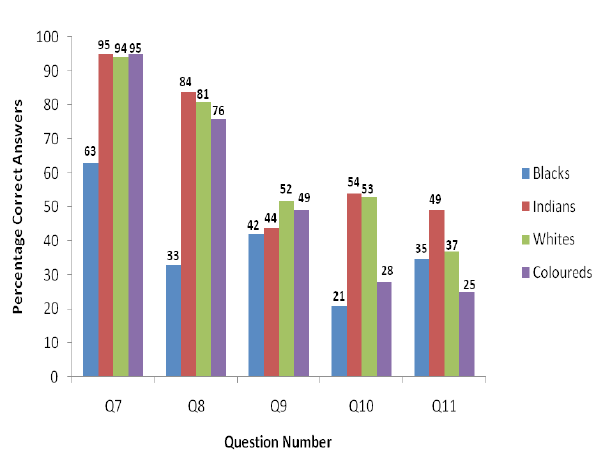
Figure 4 : Showing the percentages of respondents who reported ‘Yes’, ‘No’ and ‘no idea’ to questions 7-11. Generally, correct responses were low, being less than 50% in most of the ques- tions.